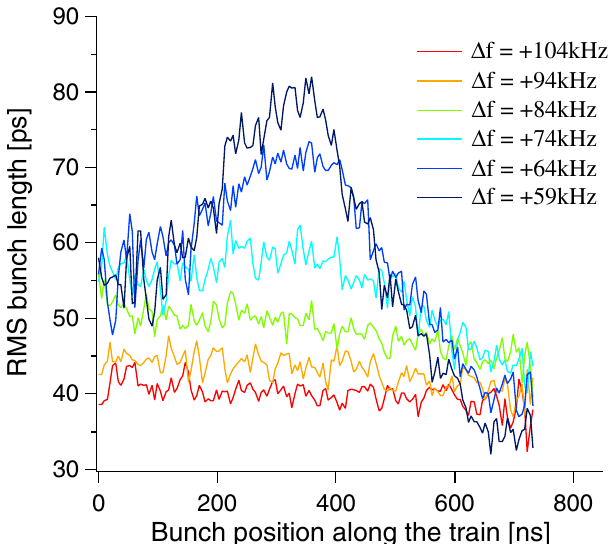
(cid:1) 315 mA , E (cid:1) beam